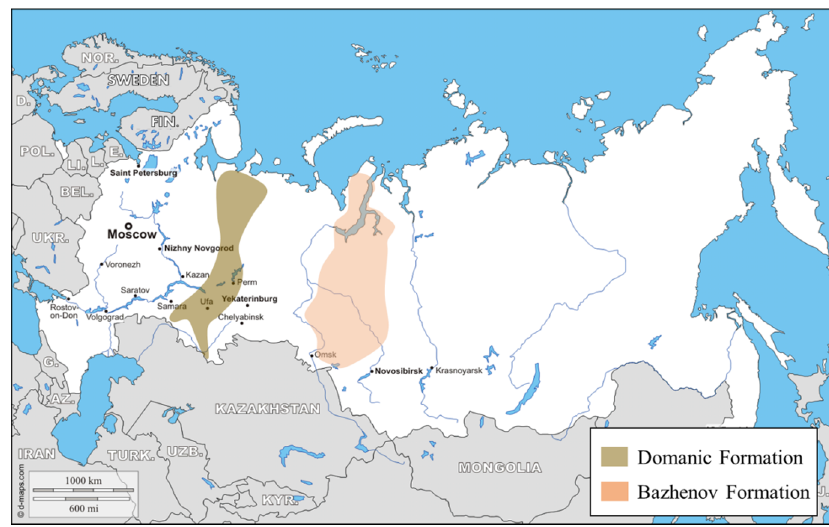
Figure 1. The geographical location of the Bazhenov and the Domanic formations.